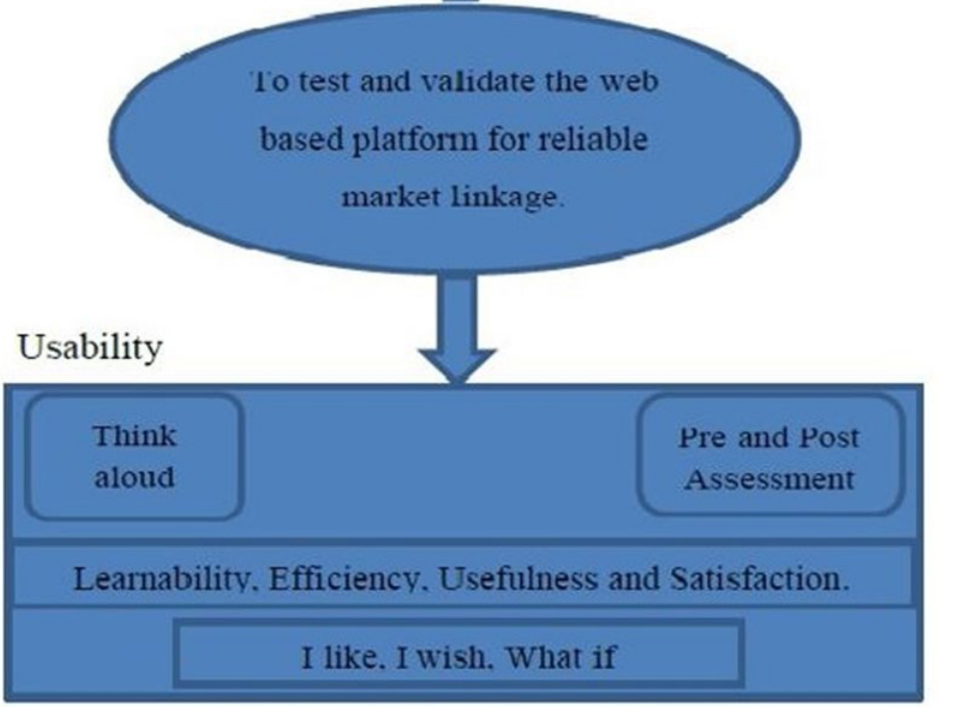
Figure 6. Usability testing model,